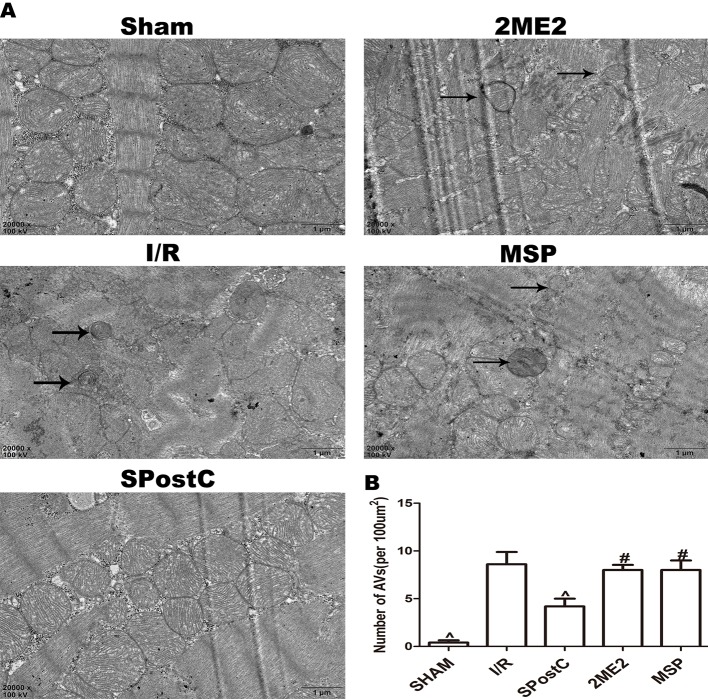
SPostC reduced the damage of mitochondrial ultrastructure and the accumulation of autophagosomes in non-diabetic state. (A) Representative transmission electron micrographs show mitochondrial ultrastructure and autophagosomes in the ischemic myocardial after 2 h of reperfusion. (B) Quantitative analysis of autophagosome. Autophagosome are indicated by the black arrow. The transmission electron microscope image was magnified 20,000 times. (^P < 0.05 vs I/R, #P < 0.05 vs SPostC) n = 5/group).